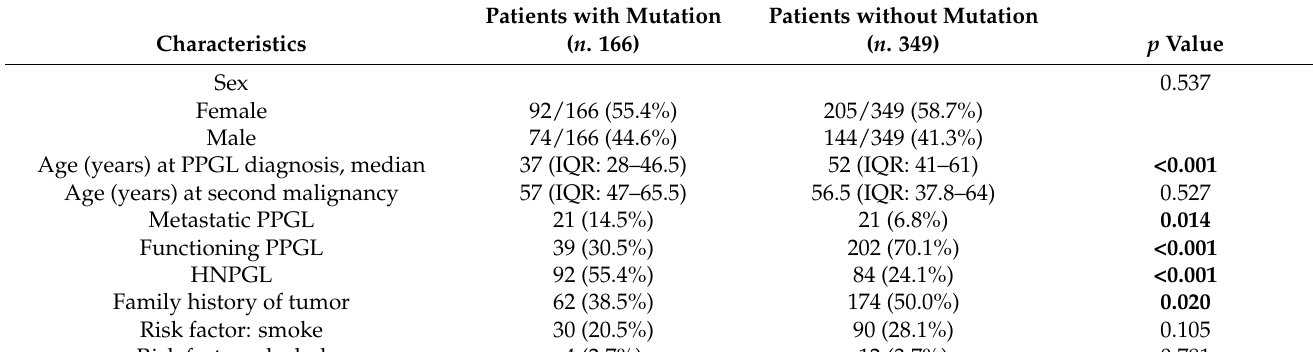
Table 2. Patient characteristics stratified by genetic